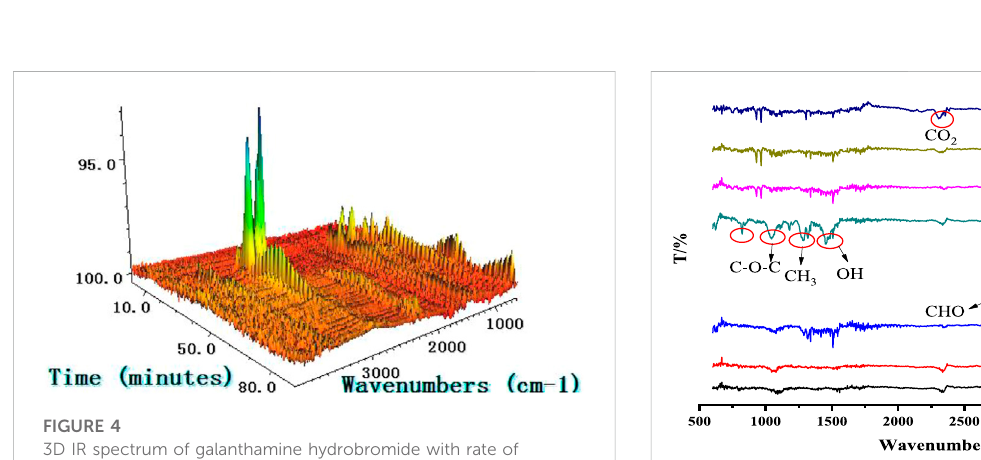
FIGURE 4 3D IR spectrum of galanthamine hydrobromide with rate of 10 K min − 1 .